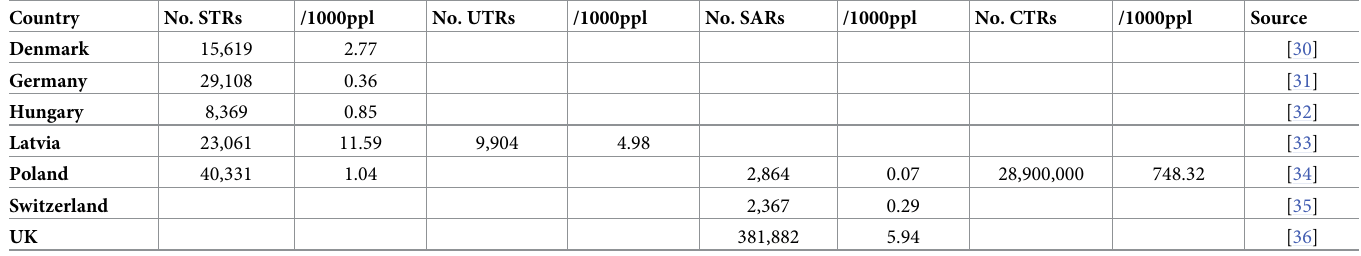
Table 1. SRs in 7 European countries in 2015, in absolute terms and per capita.